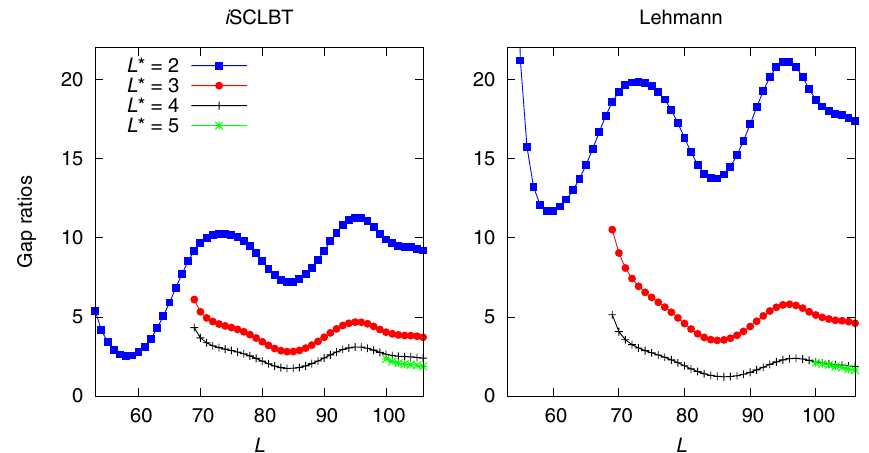
Figure 3. Comparison of ground-state lower bound gap ratios calculated by the i SCLBT and Lehmann methods for the Hubbard model. The blue, red, gray, and green lines indicate the i SCLBT and Lehmann calculations at L ∗ = 2 , L ∗ = 3 , L ∗ = 4 , and L ∗ = 5 ,